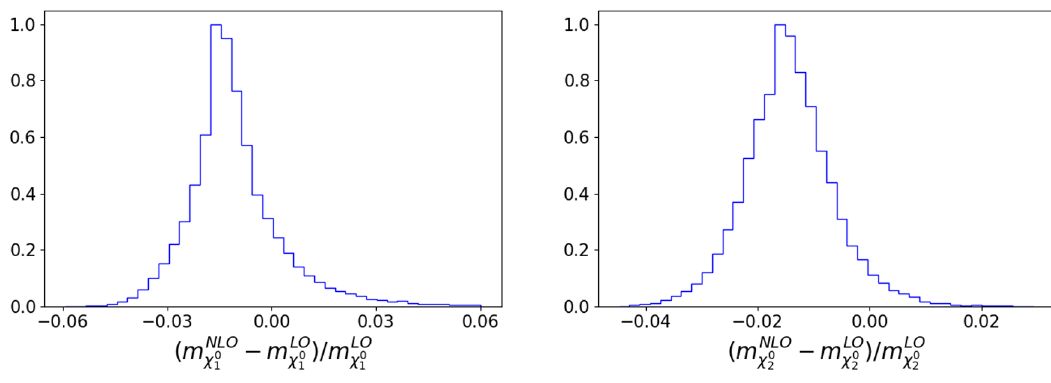
Figure 4 . Histogram showing the relative impact of the higher-order corrections for the lightest ( m , left) and the second-lightest ( m χ 0 1 as in figure 2.